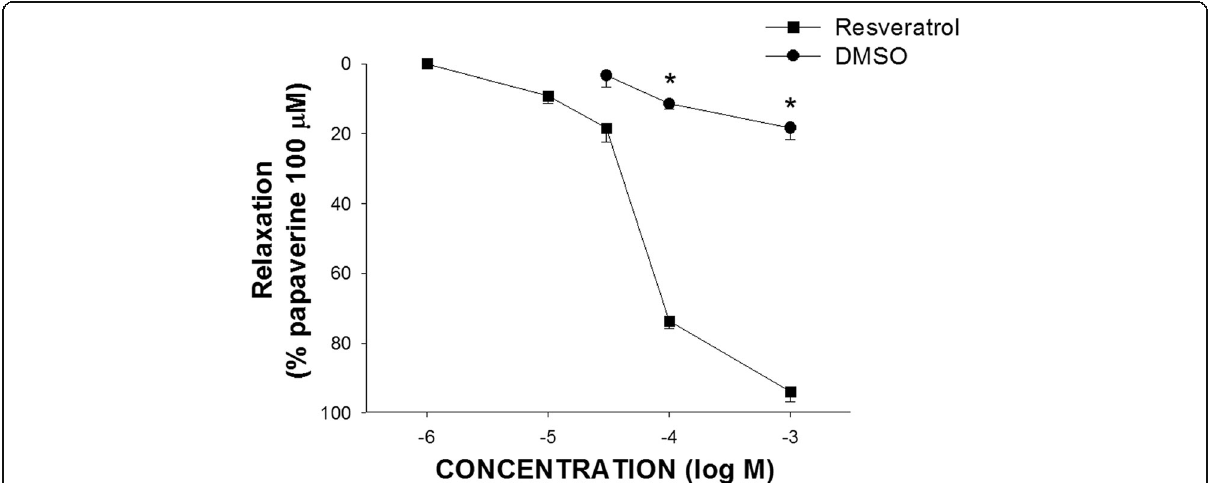
Fig. 2 The ability of resveratrol or dimethyl sulfoxide (vehicle) to induce relaxation of human gallbladder muscle strips. Resveratrol-induced relaxation in the human gallbladder muscle fiber in a dose-dependent manner. The values are expressed as a percent of a papaverine (100 μ M)-induced relaxation. The results given are from at least four experiments. The vertical bars represent ± standard error of the mean (SEM). * represents a significant difference compared with the relaxation induced by resveratrol ( p < 0.05)